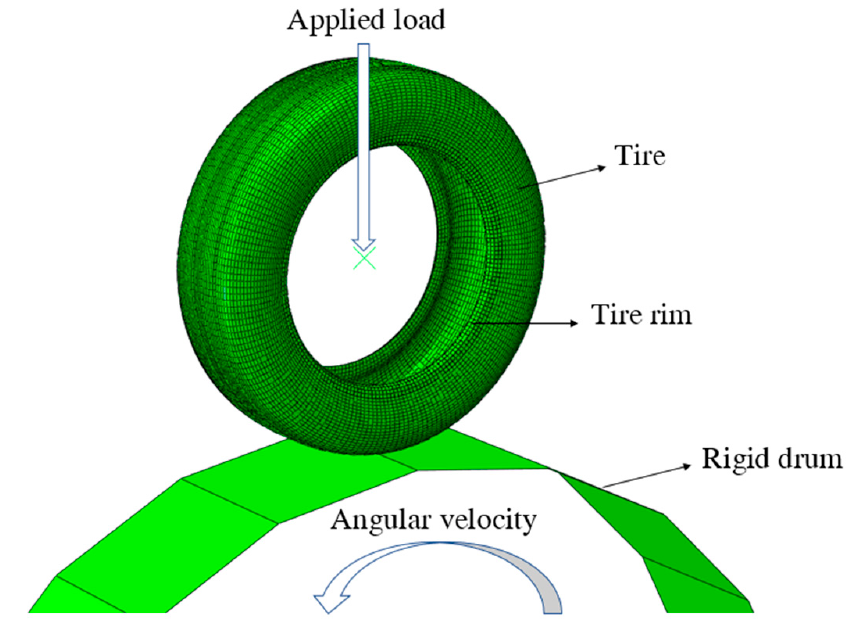
Figure 4. The tire-drum finite element model for standing waves.